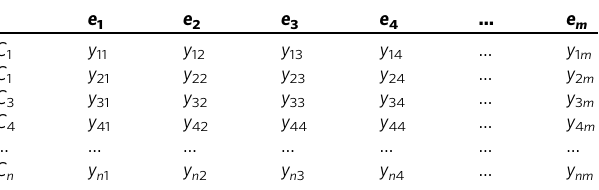
Table 1 n circumstance-by- m efforts